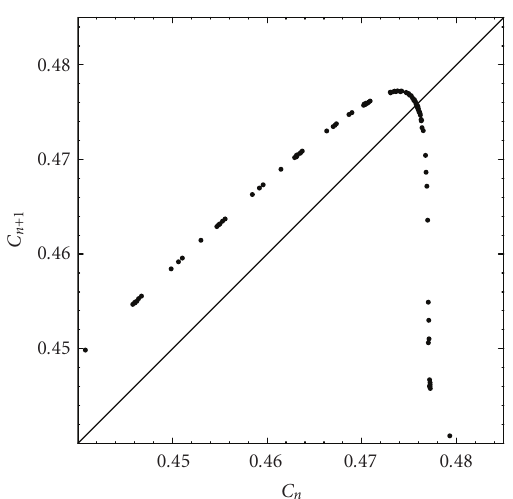
Figure 2.12. The iterated map constructed from the successive local maxima of calcium concentra- = 11 . 0 s − 1 tions ( g ∗ K , C